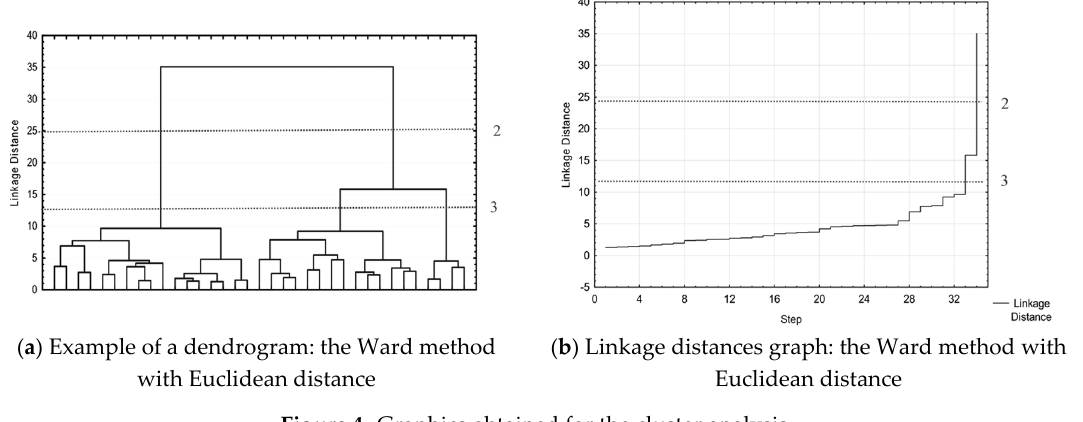
Figure 4. Graphics obtained for the cluster analysis.